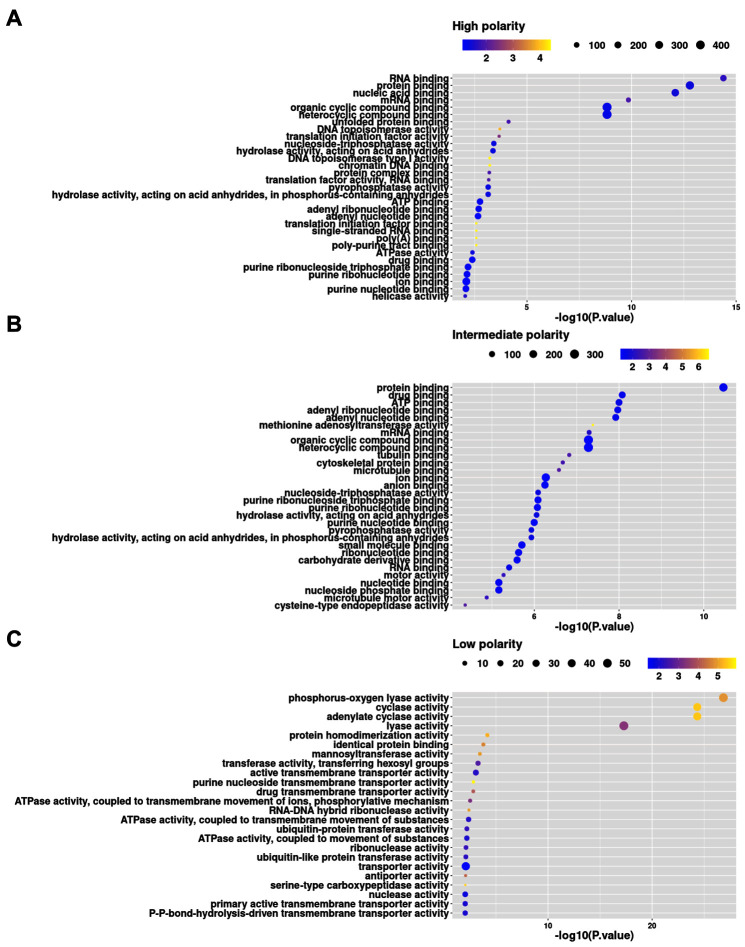
Graphical representation of the -log10 of the p-value obtained with the molecular function Gene Ontology (GO) term analysis for proteins that possess low-complexity regions (LCRs) of either High (
A), Intermediate (
B) or Low (
C) polarity indices. Gradient indicate the log2 fold-change and the size of the dots represent the numbers of proteins.